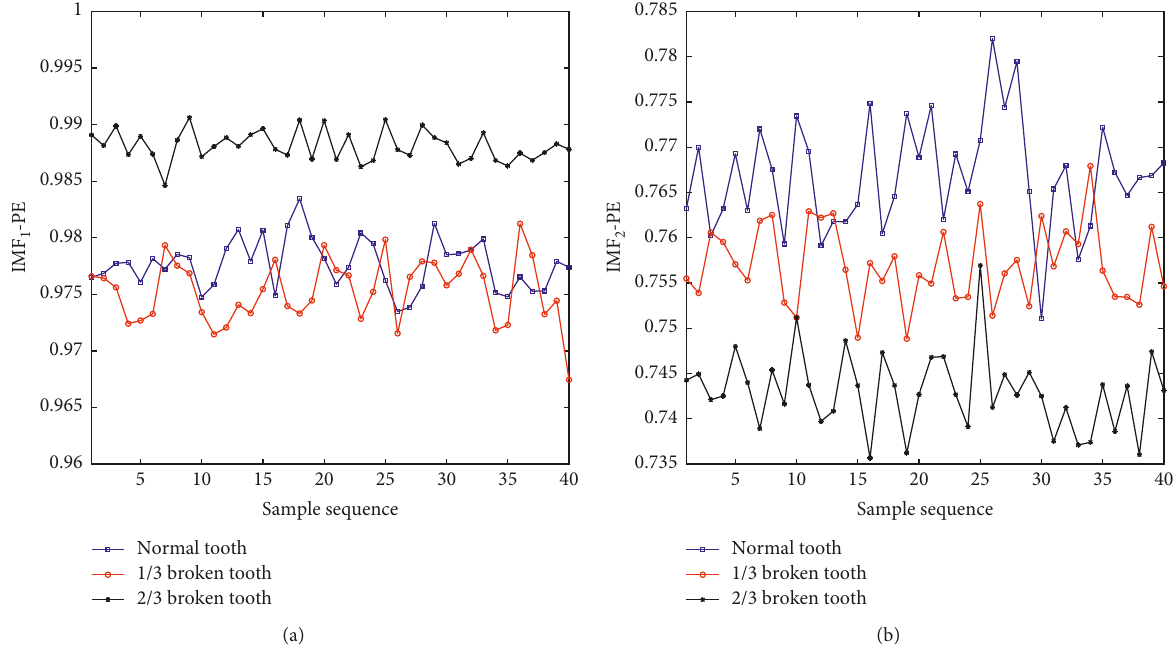
Figure 9: Comparison of EEMD-based permutation entropy of three states. (a) Permutation entropy of IMF IMF 2 .